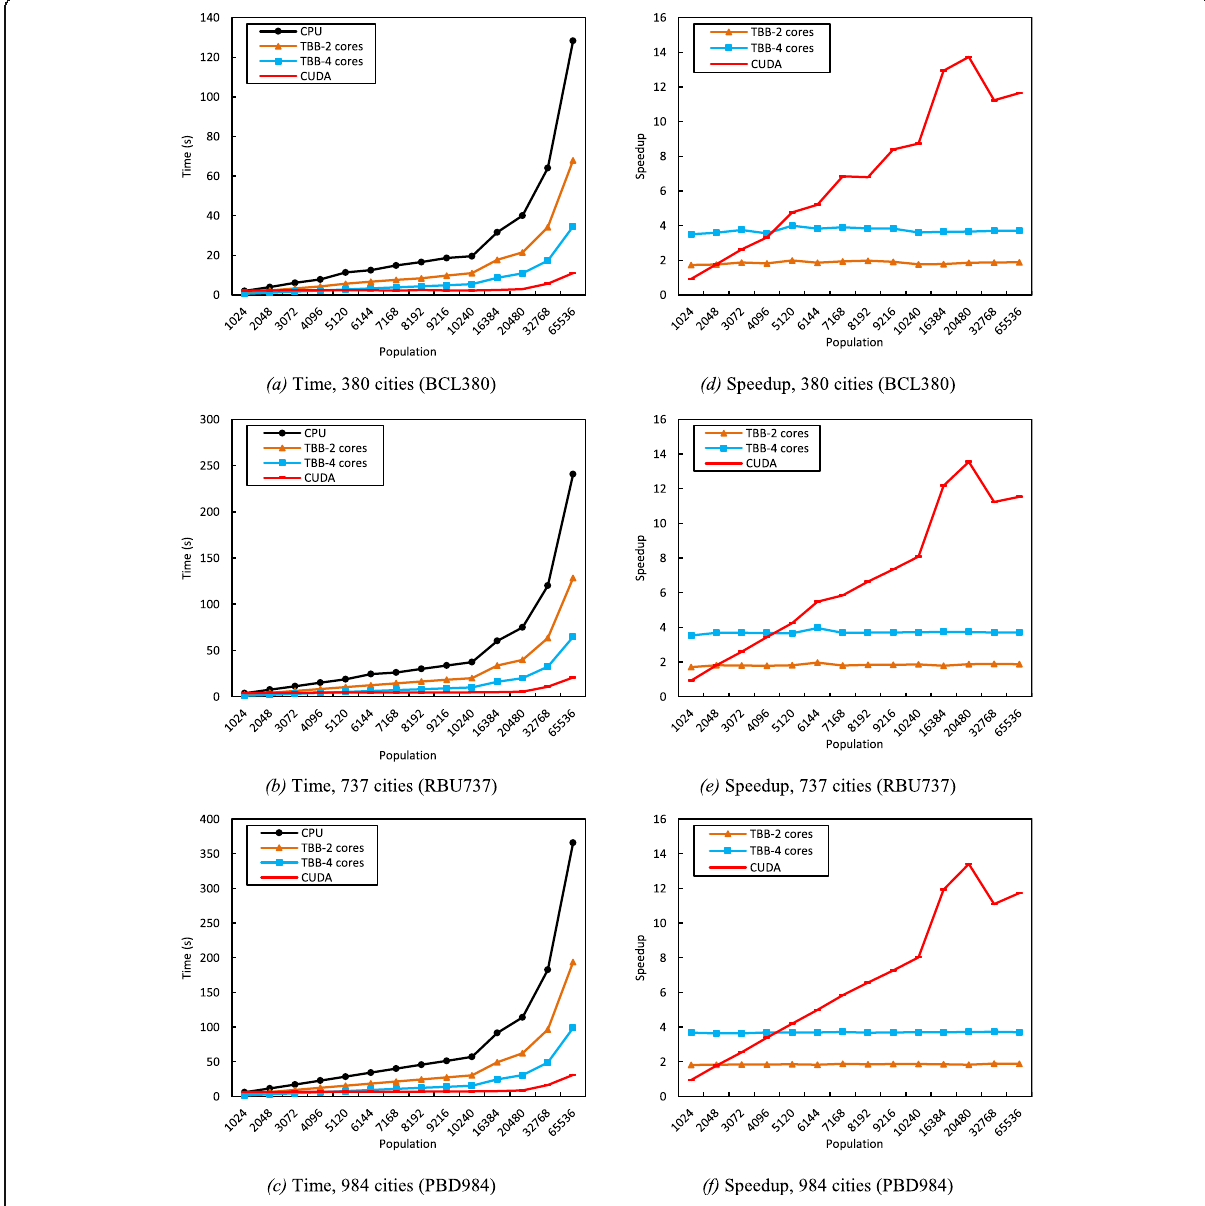
Fig. 8 The impact of population size on the speedup of parallel methods. Each subplot is labeled with the corresponding population size